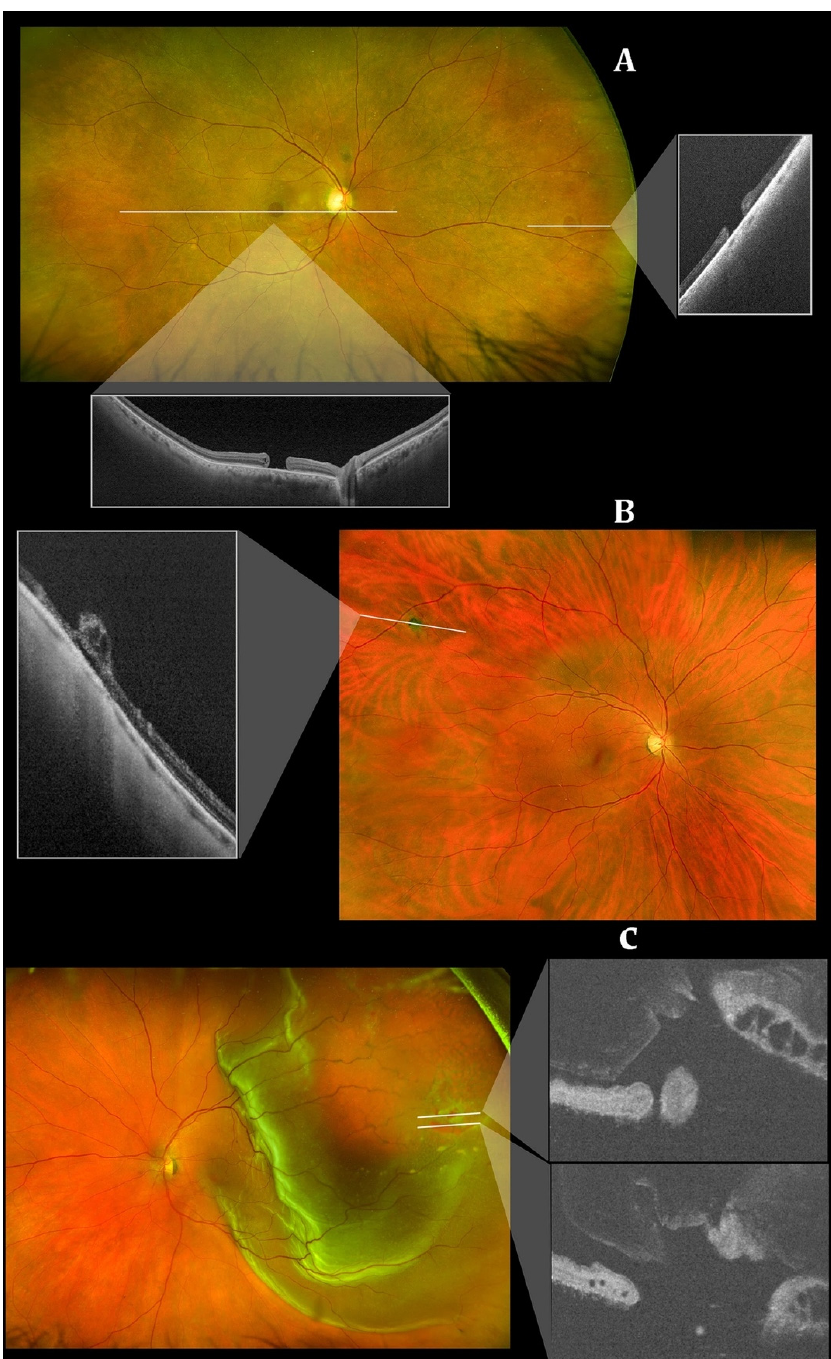
Figure 7. Integrated scanning laser ophthalmoscope and ultra-widefield imaging for peripheral optical coherence tomography with Optos’ Silverstone swept-source optical coherence tomography (Optos PLC, Dunfermline, UK). ( A ) A peripheral atrophic retinal hole (right rectangle) and macular hole (lower rectangle). ( B ) A cystic retinal tuft in the peripheral retina. ( C ) A retinal detachment in the peripheral retina. Reprinted with permission from Sodhi et al. [96]. Feasibility of peripheral OCT imaging using a novel integrated SLO ultra-widefield imaging swept-source OCT device. Int Ophthalmol 2021;41(8):2805-15 with license permissions obtained from Creative Commons; Creative Commons Attribution 4.0 International License (CC BY 4.0, https://creativecommons.org/licenses/by/4.0/legalcode (accessed on 1 August 2022)).